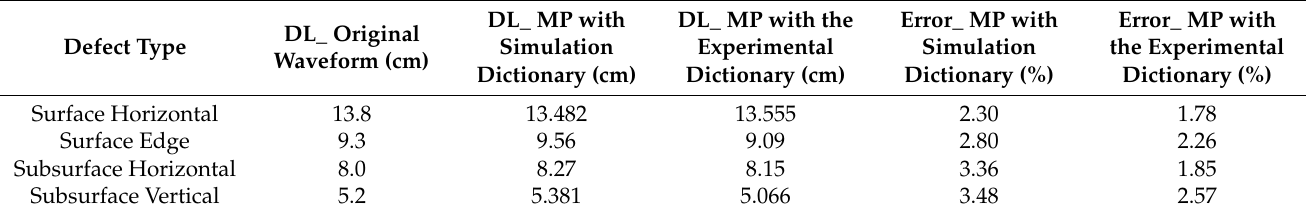
Table 3. Comparison of MP with FEM simulation and experimental dictionaries to locate railhead surface and subsurface defects.